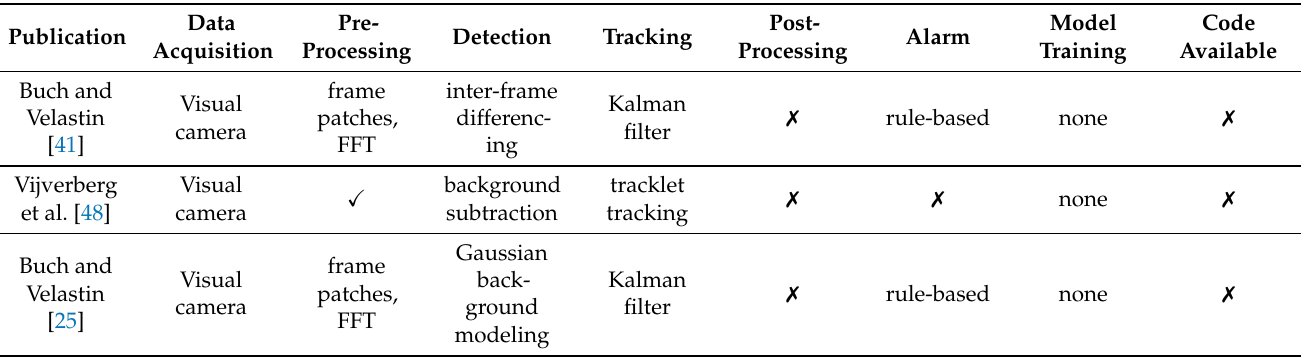
Table 2. PIDS reviewed by chronological order, where columns represent steps of the pipeline, along with model training needs and availability of source code. (cid:55) denotes unavailability of the step, whereas (cid:88) denotes that the step is available but not